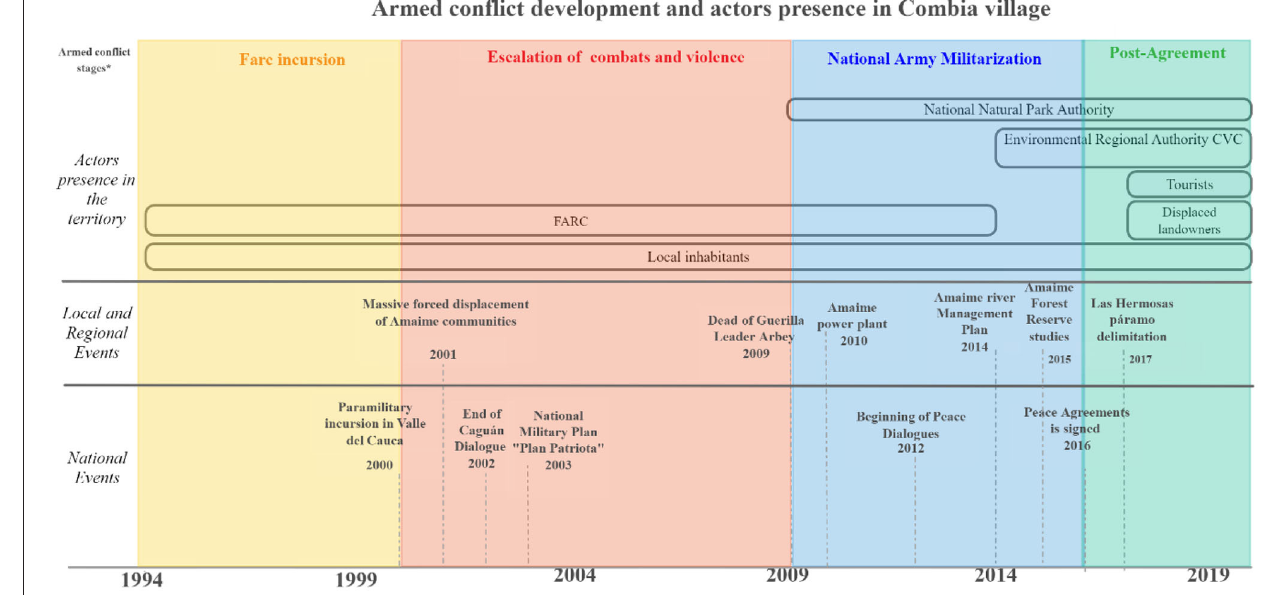
FIGURE 4 | Timeline showing the armed conflict and major environmental events and their relationship with actors’ presence. Own